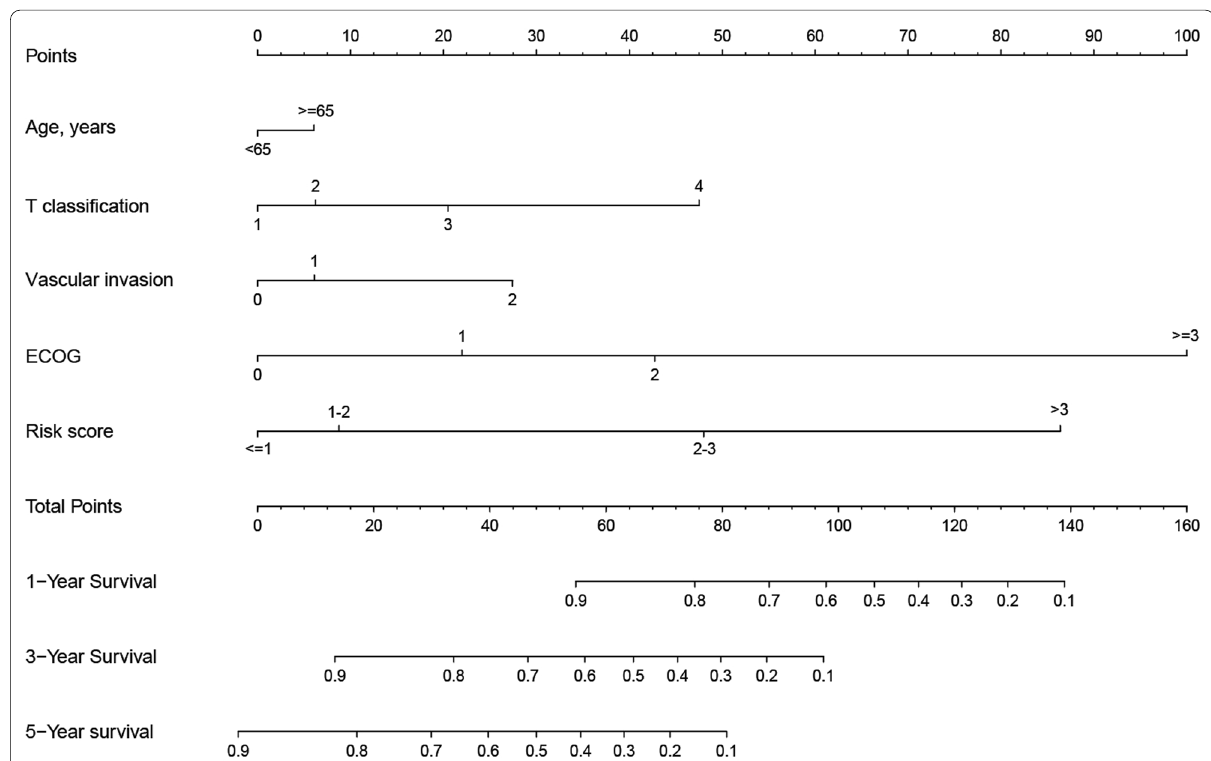
Fig. 8 Prognostic nomogram was established by combining clinicopathological parameters and risk